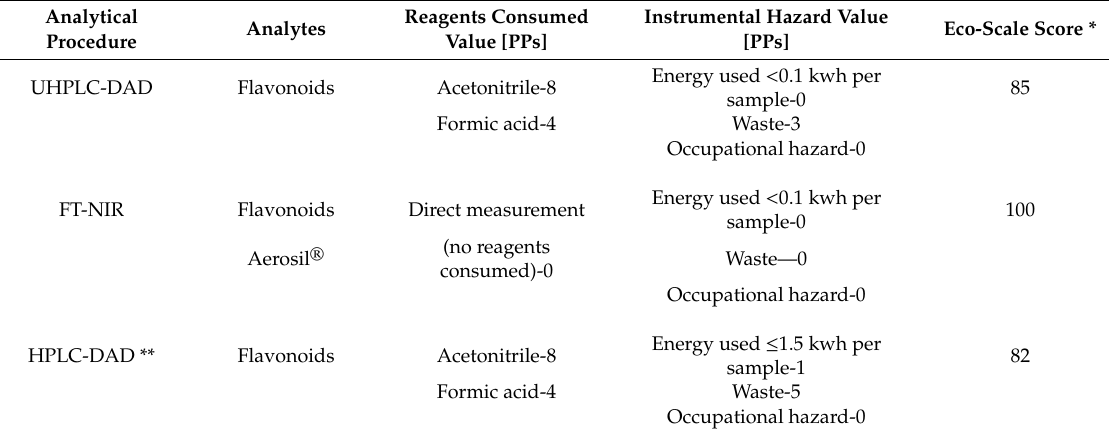
Table 2. Analytical parameters comparison and eco-scale score obtained for the UHPLC and NIR methodologies applied to the analysis of herbal medicine dried